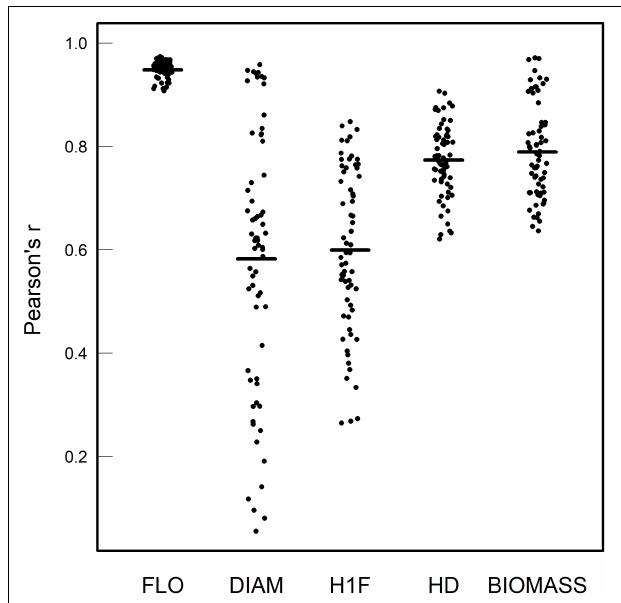
FIGURE 2 | Pairwise genetic correlation coefficients of Pearson among the 12 treatments for each phenotypic trait. The dots correspond to the 66 pairwise treatment combinations. Black segments correspond to the mean value of Pearson’s r